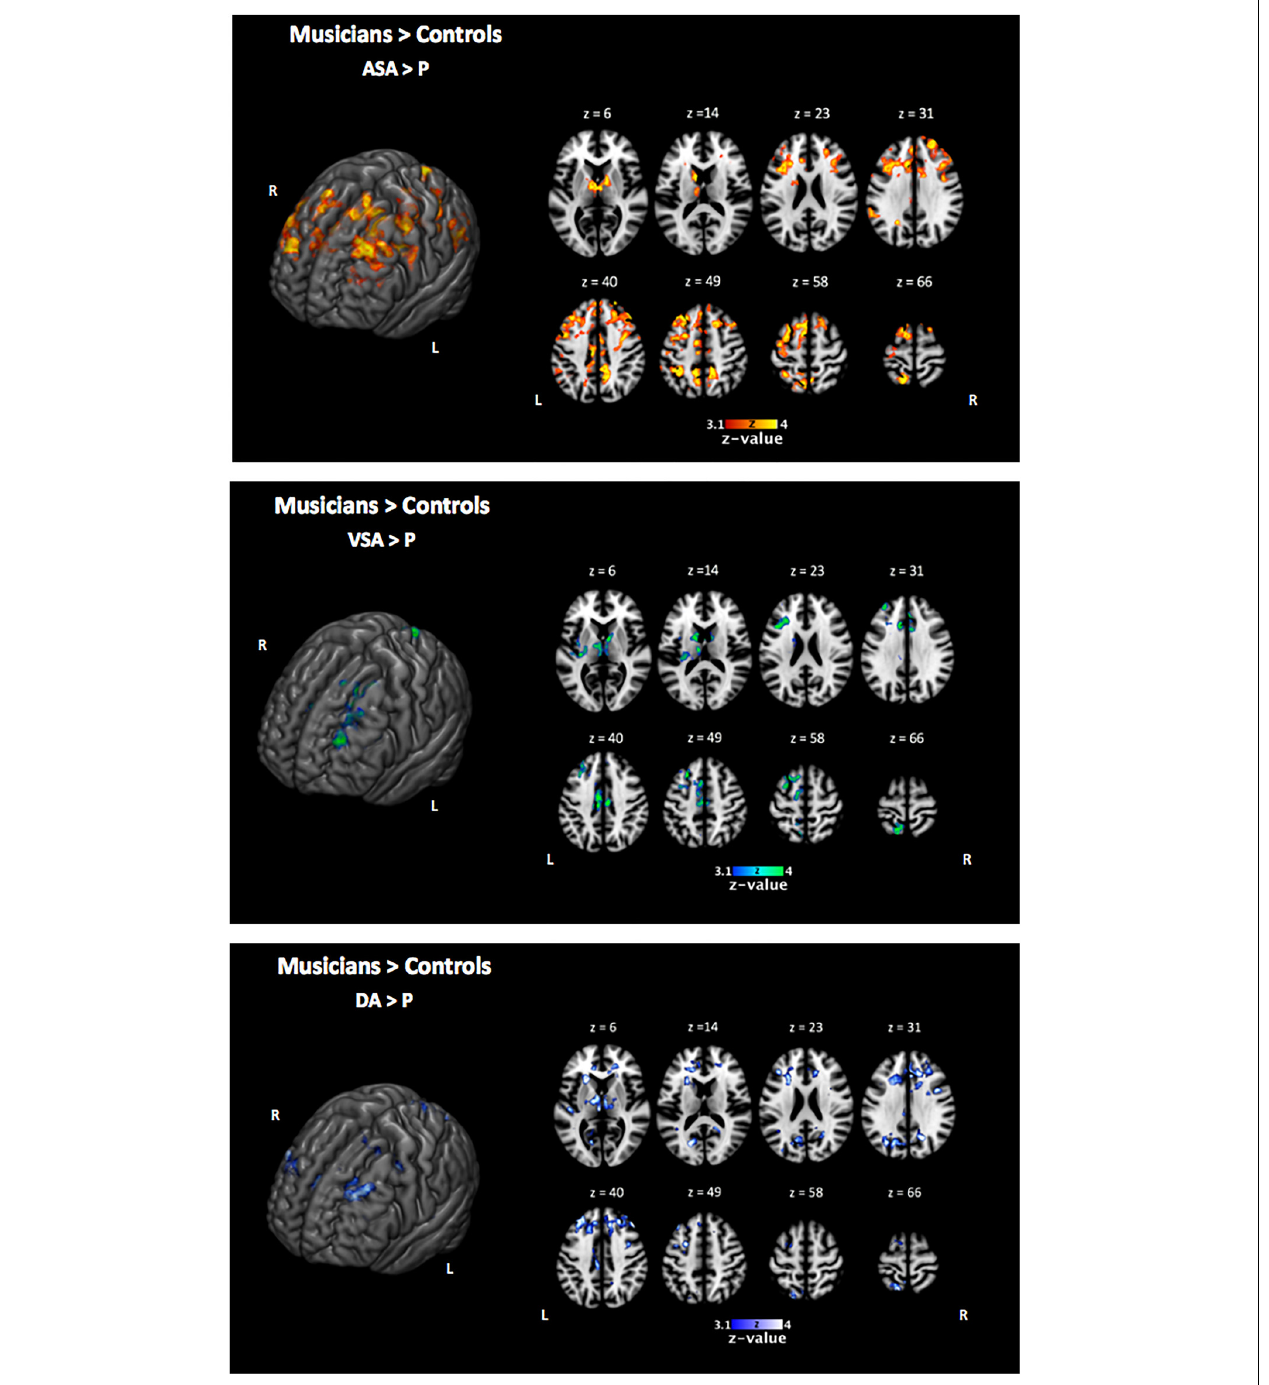
FIGURE 3 | Two-sample comparison of musically trained children over control children during encoding phase [ASA > P], [VSA > P], and [DA > P] contrasts (corrected p < 0.05). ASA, auditory selective attention condition; VSA, visual selective attention condition; DA, divided attention condition; P, passive condition.